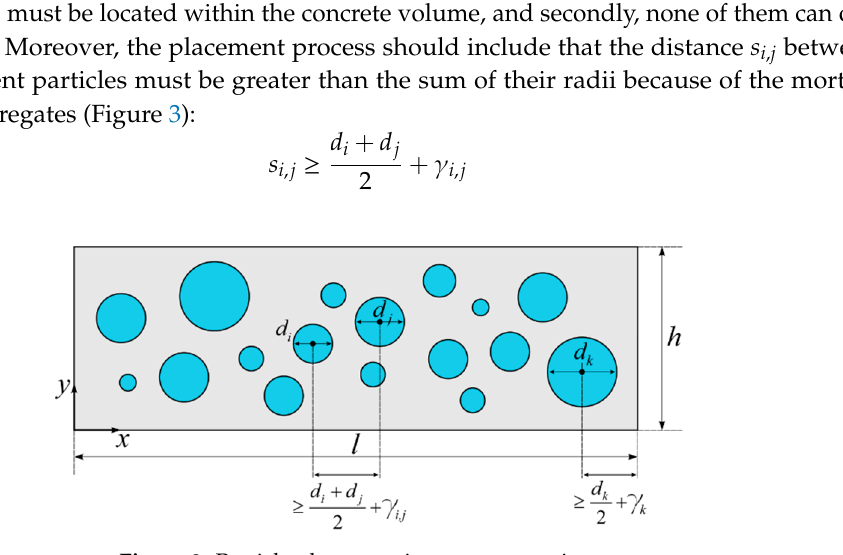
Figure 3. Particle placement in concrete specimen.